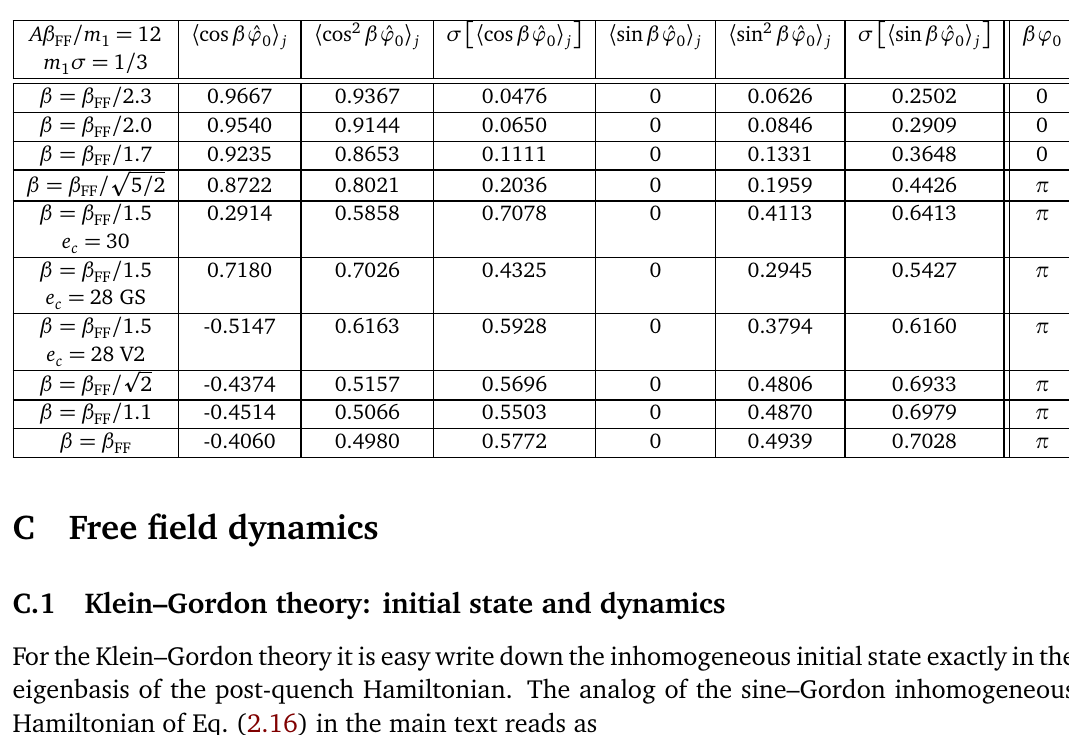
Table B.4: The zero mode in the quantum inhomogeneous state, from TCSA, e 〉 m L = 20. 〈 denotes the expectation value of operator j 1 O (cid:3) (cid:2) 〈 〉 is the standard deviation characterising the fluctuations. initial state, while σ j O = 28 ground state and first excited state (V2) are shown as well, For R = 1.5, the e c = 30 ground state displays the effects of hybridisation (c.f. Appendix B.1 since the e c for more